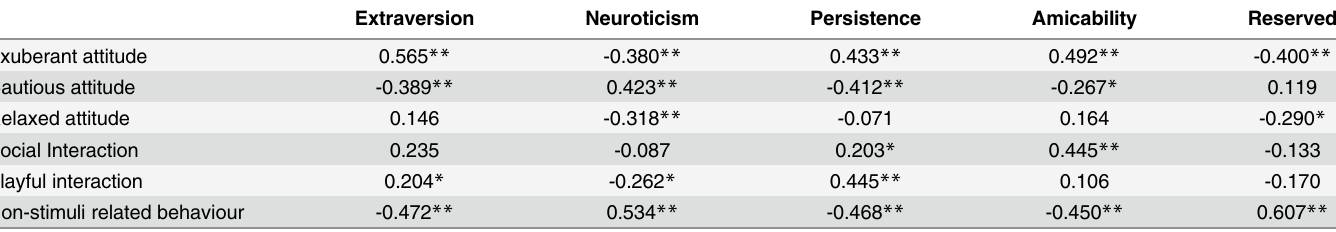
Table 6. Pearson ’ correlation coefficient and significance levels used to assess the correspondence between the behaviour factors identified by the hierarchical cluster analysis (rows) and personality factors emerging from the questionnaire-based analyses